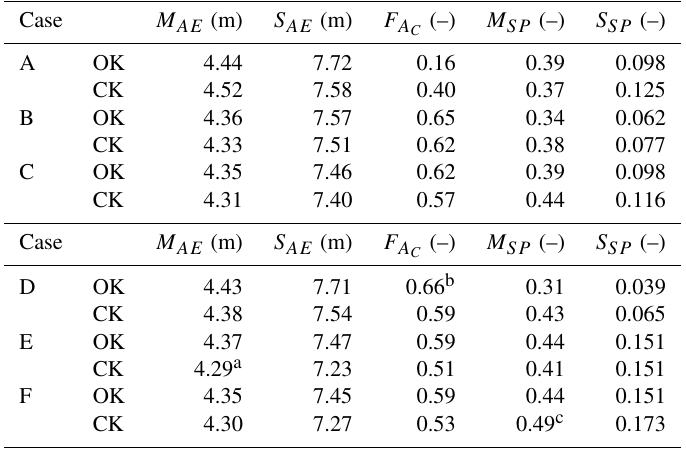
Table 4. Cross-validation results from ordinary kriging (OK) and co-kriging (CK) with model parameters corresponding to cases given in Table 3.